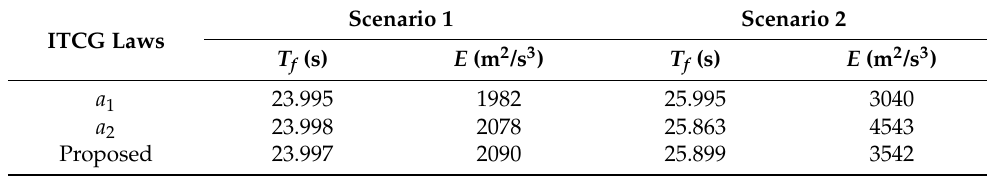
Table 5. Simulation results under different ITCG laws.